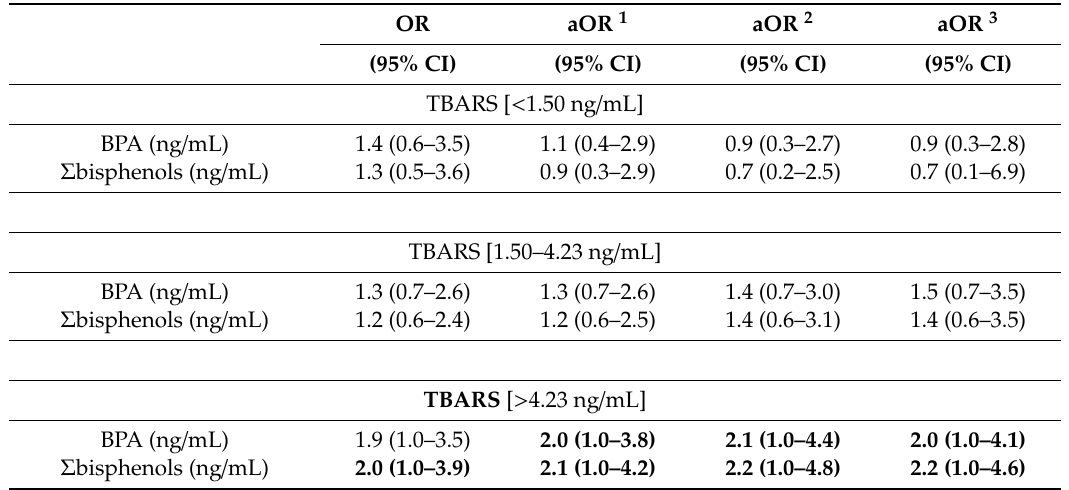
Table 5. Association between urinary bisphenols and endometriosis by tertiles of urinary